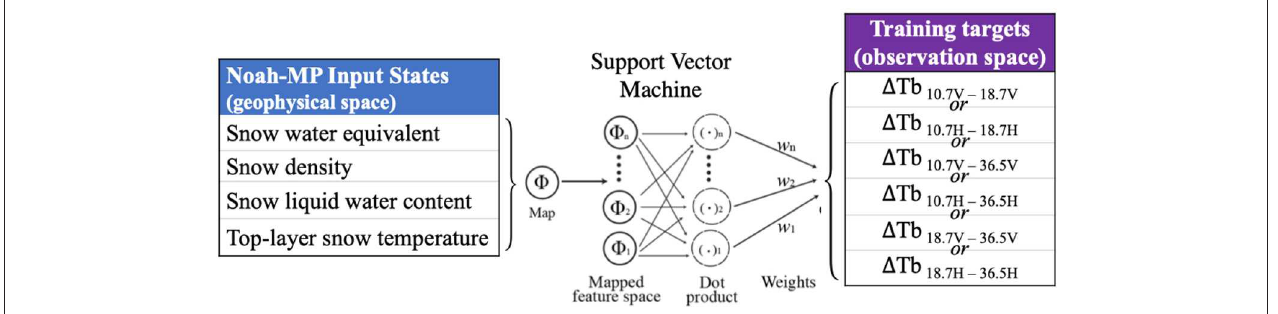
FIGURE 2 | Schematic of the SVM prediction framework (see Table 3 for details about 1 Tb).